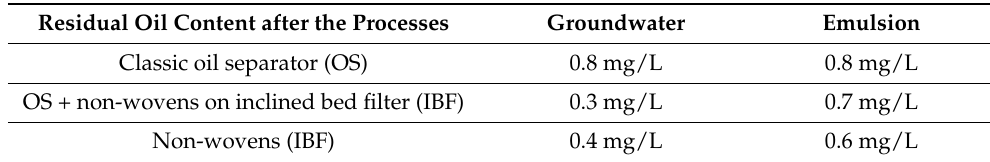
Table 8. Oil removal from water using non-wovens. Residual Oil Content after the Processes Groundwater Emulsion Processes Classic oil separator (OS) OS + non-wovens on inclined bed filter